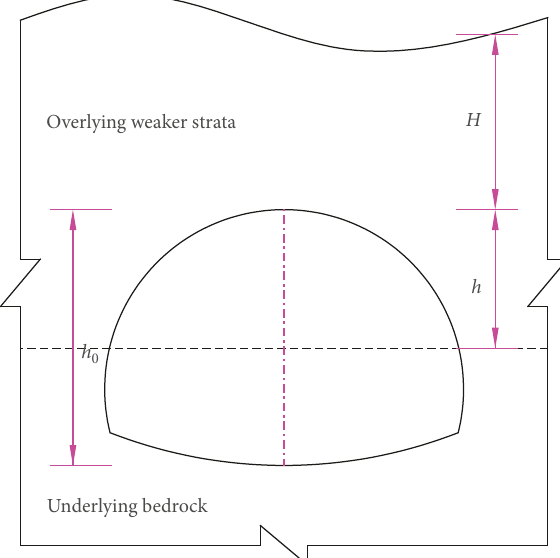
Figure 8: Invasion thickness definition schematic.